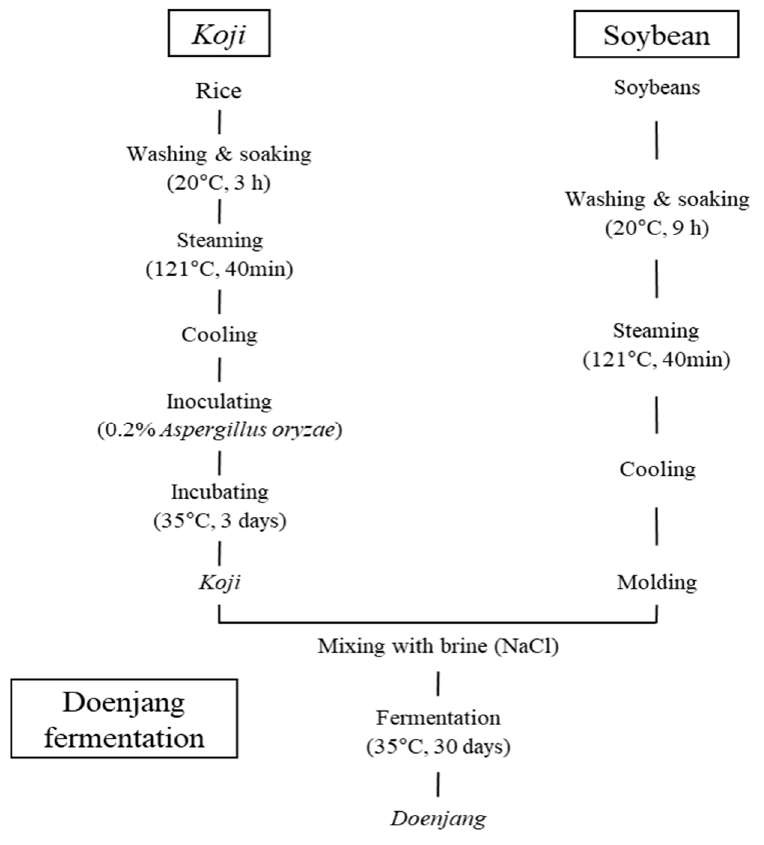
Figure 1. Diagram of doenjang sample preparation in this study.